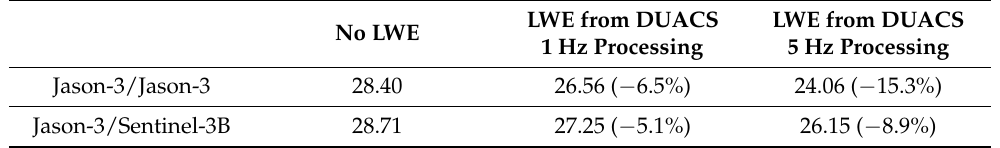
Table 3. Mean variance in SSH differences at Jason-3/Jason-3 and Jason-3/Sentinel-3B cross-overs over the year 2019, when no LWE correction is applied or when the LWE correction obtained using the DUACS 1 Hz or 5 Hz processing is applied on Jason-3. Sentinel-3B is kept as an independent mission for LWE estimation. We used 1 Hz measurements. Only cross-overs within a 10-day interval have been considered. Units are cm 2 . LWE from DUACS LWE from DUACS No LWE 1 Hz Processing 5 Hz